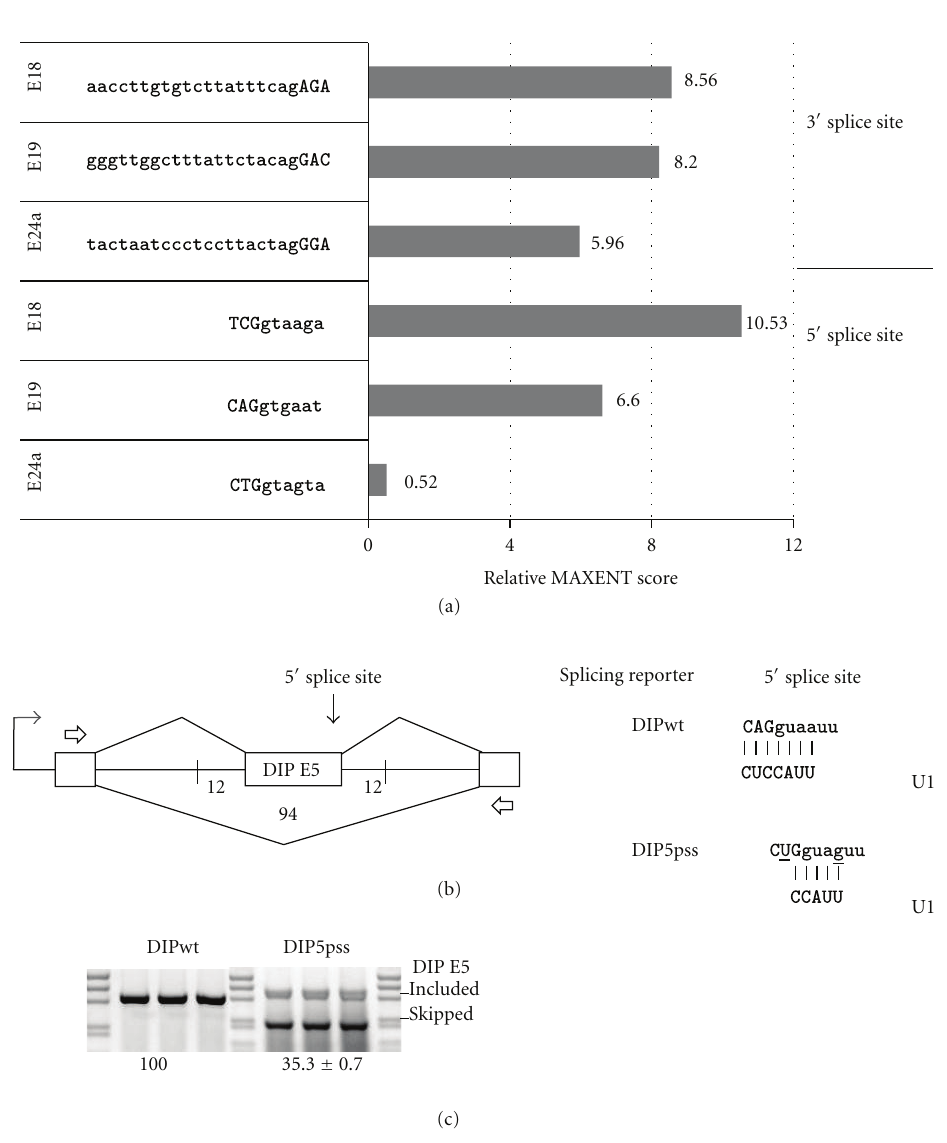
Figure 3: A noncanonical 5 (cid:2) splice site represents an unusual feature of E24a, and transplantation of this splice site renders a constitutive exon susceptible to splicing silencing. (a) Graph illustrates relative splice site scores determined using the MAXENT scoring algorithm for E18, E19, and E24a. Sequences used for scoring are shown. (b) Splicing reporter, DIPwt, contains constitutive exon, E3, as the middle exon with 12 bases of flanking intron sequence. E3 and adjacent intron sequences are derived from the mouse DIP13beta (APPL2) gene. Sequences of the 5 (cid:2) splice sites of DIPwt and DIP5pss are shown at right (5 (cid:2) to 3 (cid:2) ); vertical lines illustrate potential base pairing to U1 snRNA (3 (cid:2) to 5 (cid:2) ). The 5 (cid:2) splice site of CASK E24a was transferred into DIP5pss by constructing two-point mutations (underscored). (c) The gel panel shows results of splicing assays performed after transfecting DIPwt and DIP5pss reporters into N18TG2 cells. Transfections and RT-PCR amplification were carried out in triplicate. Numbers below gel panels represent average % exon inclusion value ± standard